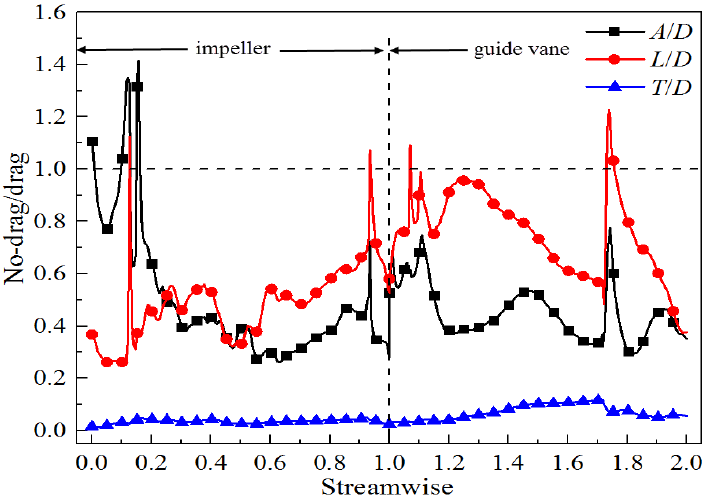
Figure 5. Magnitude ratio of non-drag forces to drag along the streamwise direction at IGVF = 21%.